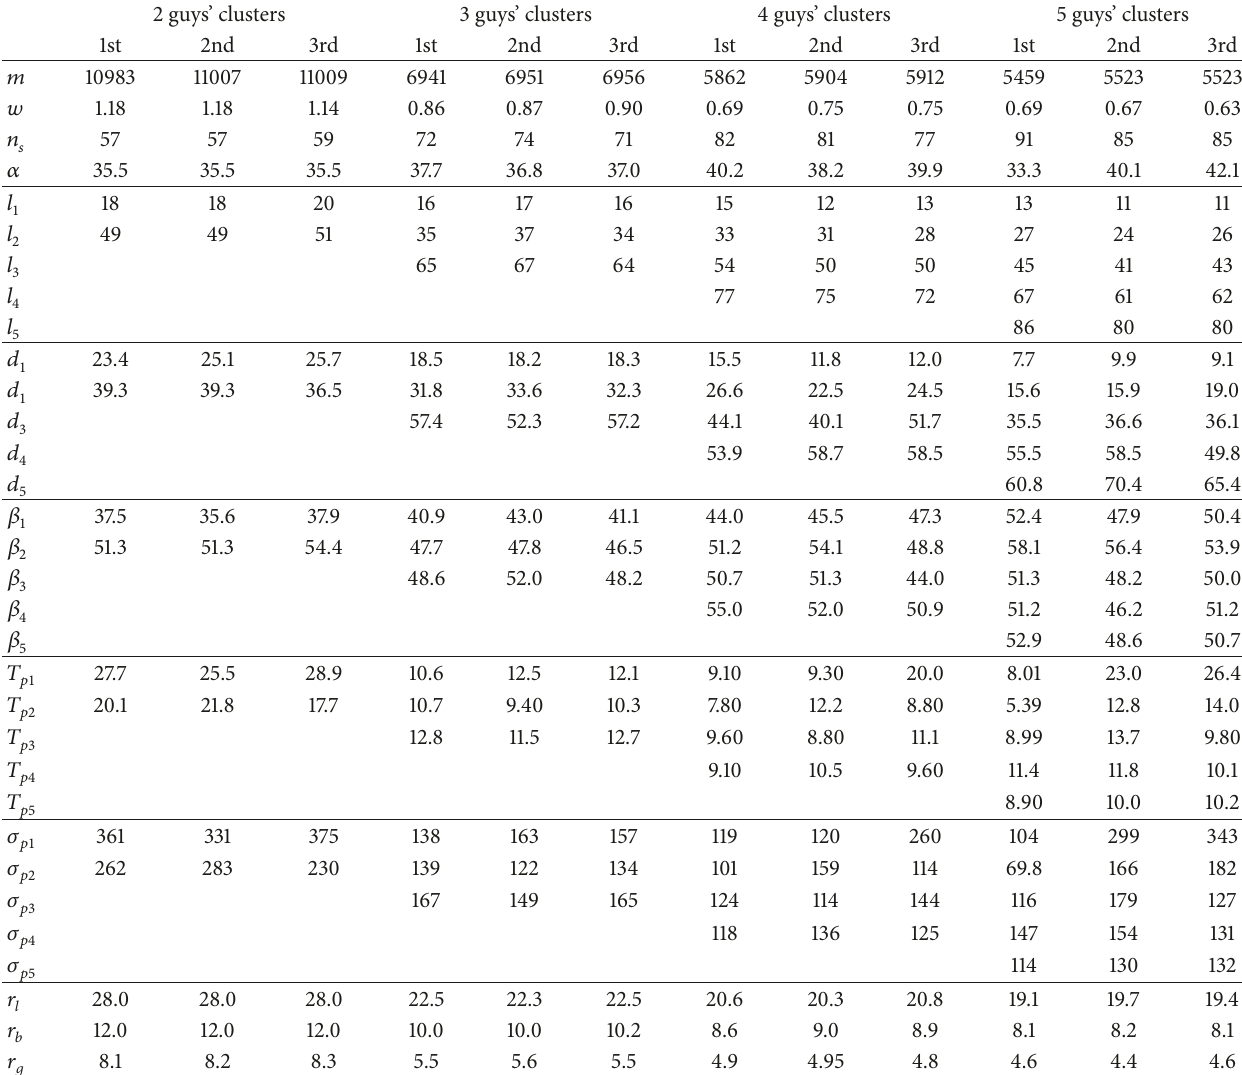
Table 3: The main optimal parameters of the best 3 solutions for 2 to 5 guys’ clusters masts ( m : total mass of the mast, kg; 𝑤 : side of the mast, m; 𝑛 𝑠 : number of sections; 𝛼 : tilt angle of bracing elements, deg; 𝑙 𝑖 : attachment level of the i th guys’ cluster; 𝑑 𝑖 : anchoring distance of the i th guys’ cluster, m; 𝛽 𝑖 : tilt angle of the guy at the i th level, deg; 𝑇 𝑝𝑖 : prestress force at the i th guy level, kN; 𝜎 𝑝2 : prestress at the i th guy level, MPa; 𝑟 𝑙,𝑏,𝑔 : radii of the leg, bracing, and guy elements,